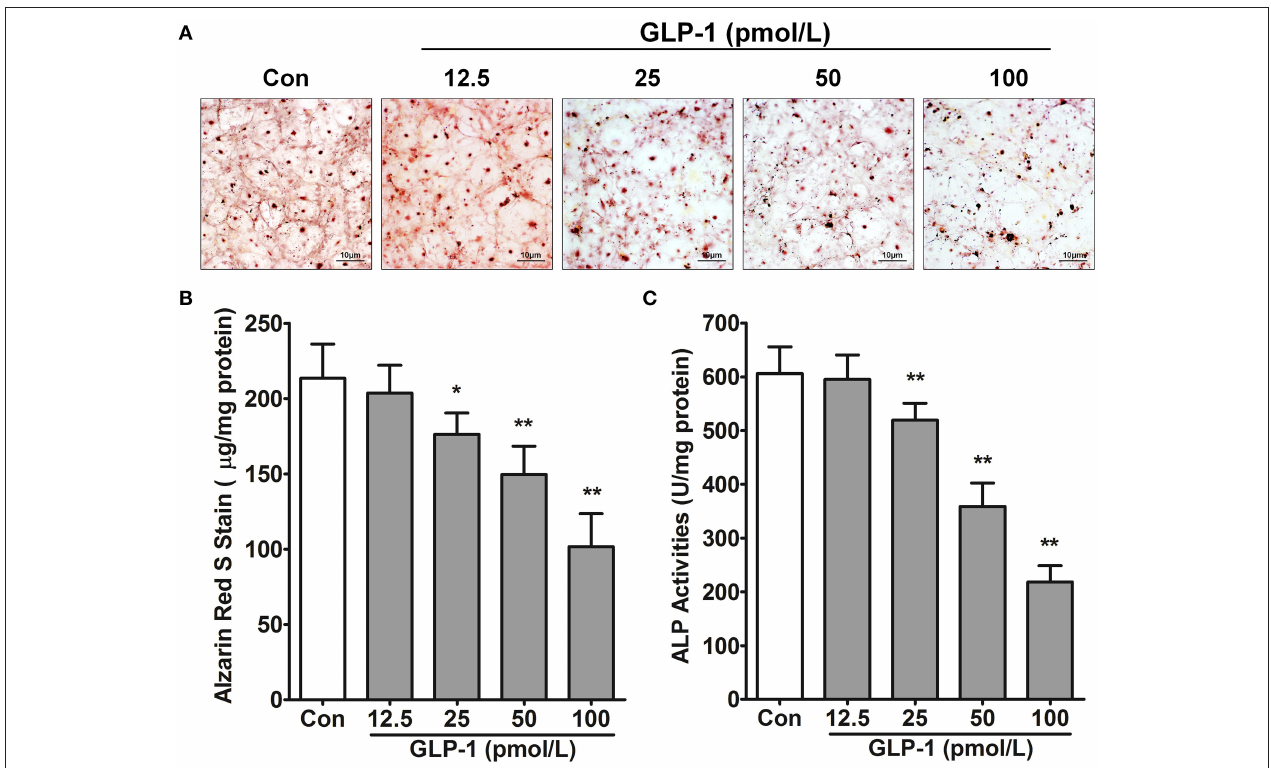
FIGURE 3 | GLP-1 inhibits AVIC calcification. In osteogenic medium, the primary AVICs were incubated with increasing doses (12.5, 25, 50, and 100 pmol/L for 21 days) of GLP-1. The group without the GLP-1 treatment was used as a control (Con). (A) Alizarin Red S was used to stain the calcification cells. The pictures were taken using Image-Pro Plus 6.0. Alizarin Red S staining is shown at 400 × magnification. (B) Quantification of Alizarin Red S staining. (C) Quantification of ALP activation in AVICs. The dye was extracted and quantified as described in the Methods section ( n = 6, mean ± SD, * P < 0.05, ** P < 0.01 compared with Con).